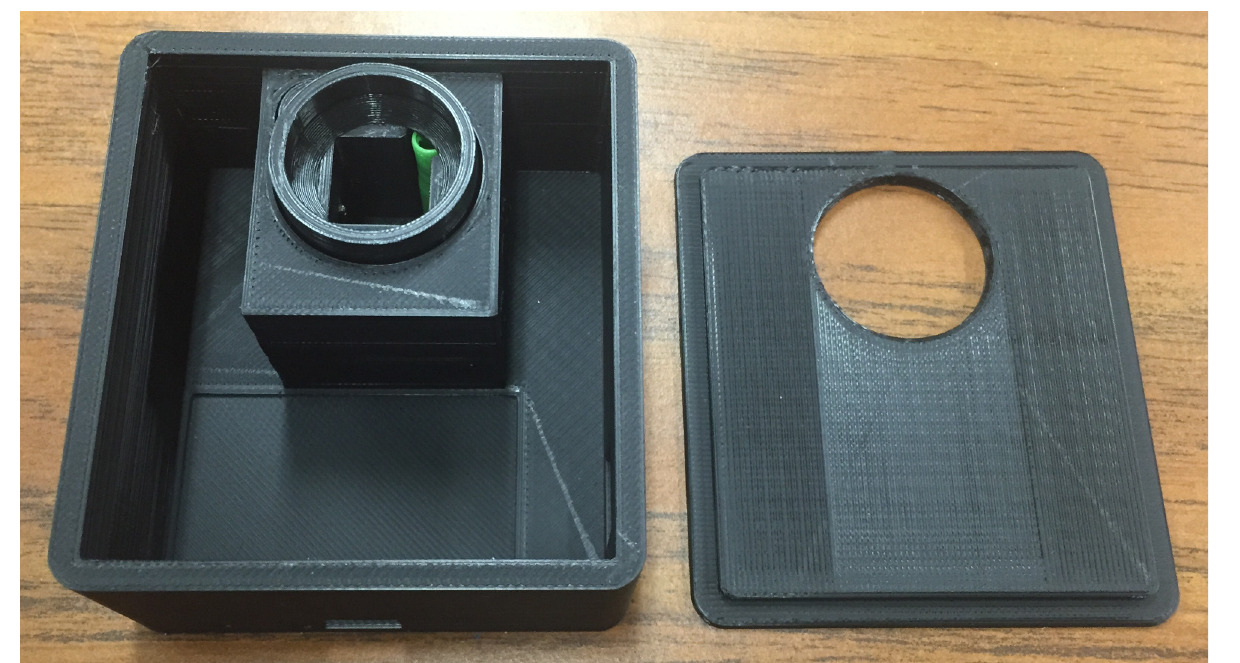
Fig 4. Photometer case with top